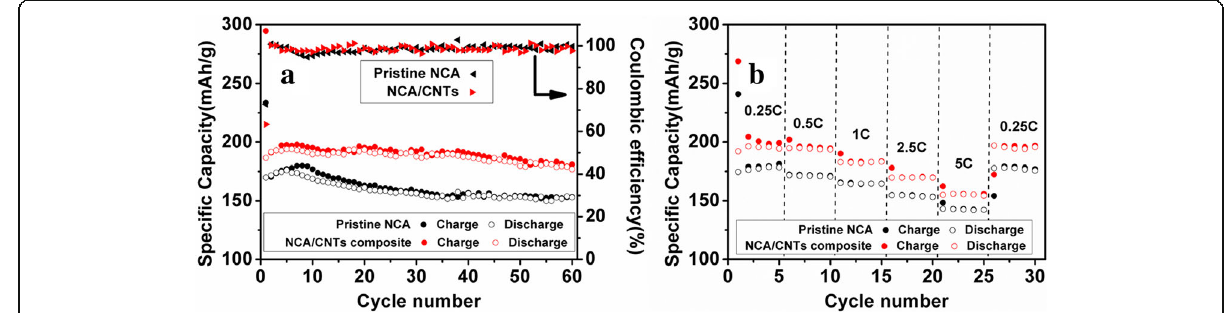
Fig. 6 a Cycling performance at 0.25 C rate. b Rate performance of pristine NCA and NCA/CNT (10 wt%)